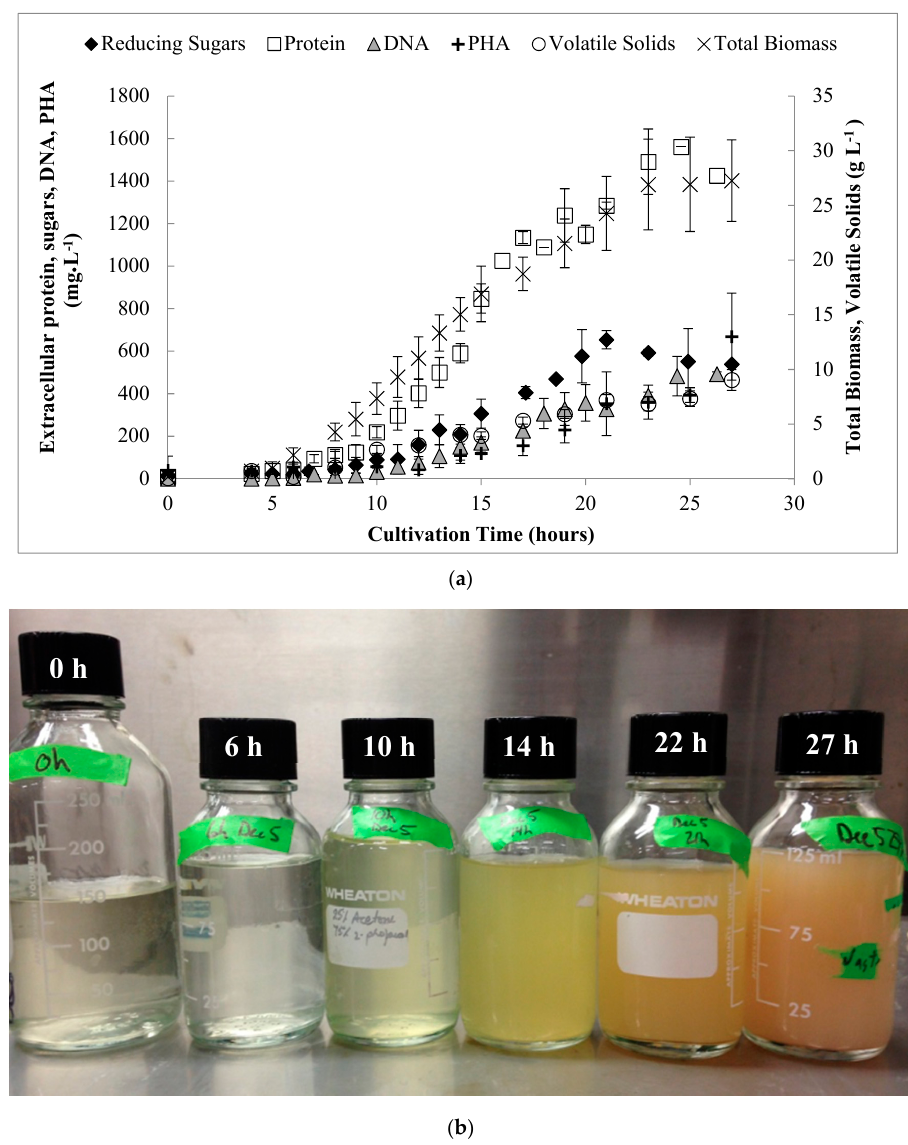
Figure 4. ( a ) Soluble (extracellular) organic material detected in the supernatant over the time course of the bench-scale cultivations, which is thought to contribute to the observed rheological behavior of the medium and ( b ) appearance of culture after centrifugation for fed-batch experiments at the cultivation time indicated. Error bars represent standard deviations between the mean values obtained from each of the biological replicate experiments.